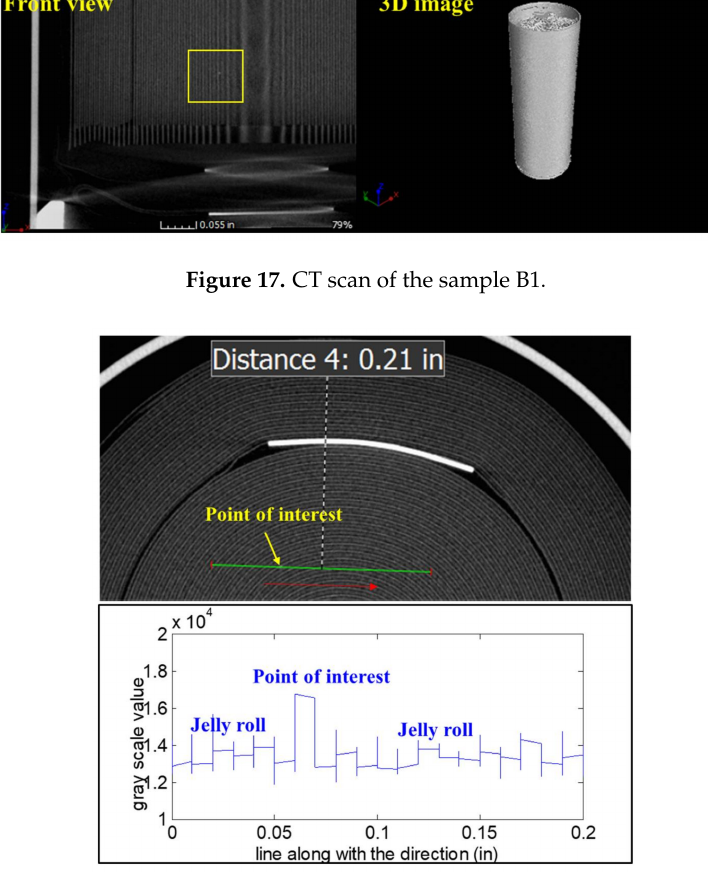
Figure 18. Point of interest of the sample B1 and the gray-scale profile along the marked green line.